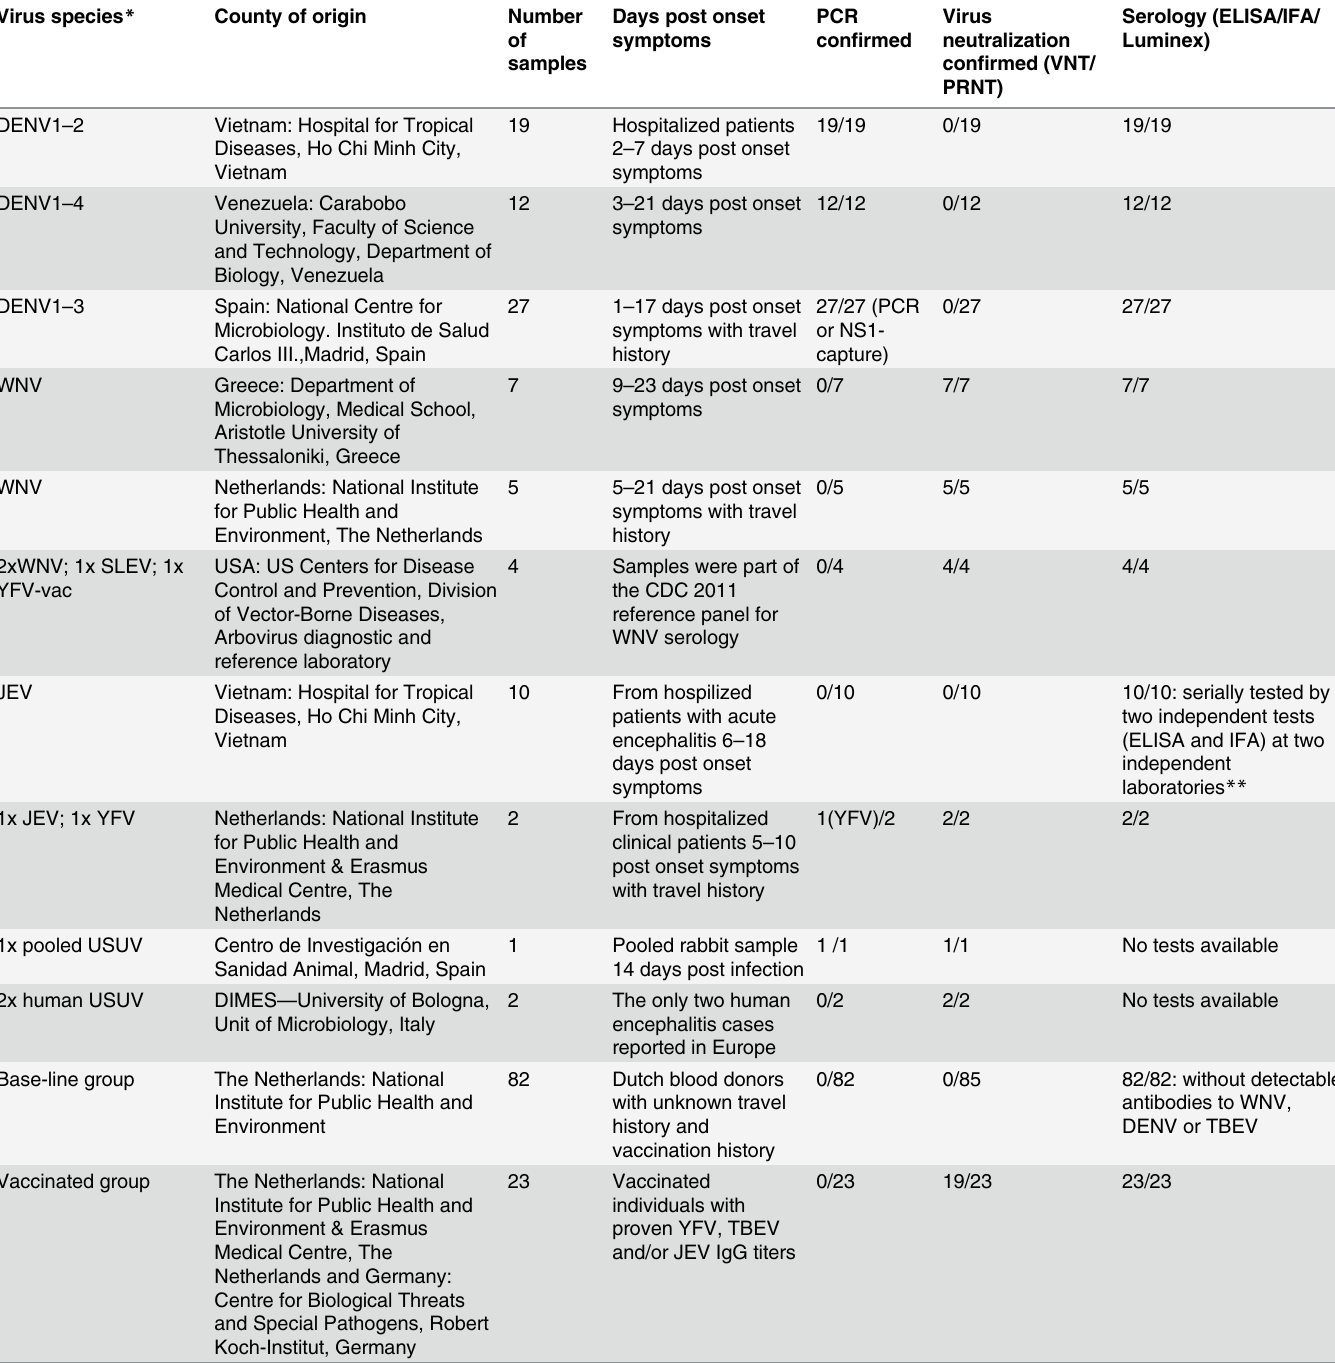
Table 1. Overview serum collection used for fl avivirus microarray development. Virus species